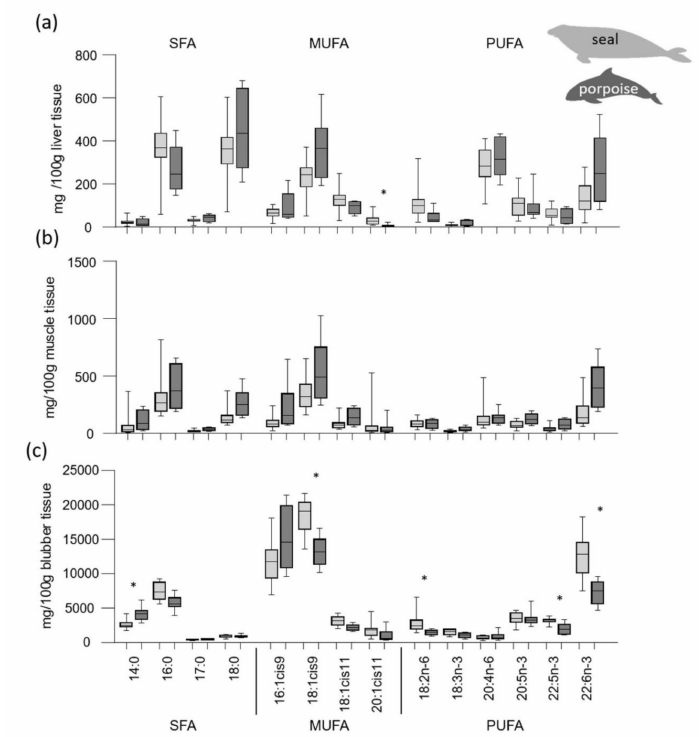
Figure 2. Single fatty acid concentrations (mg / 100 g fresh tissue) in liver ( a ), skeletal muscle ( b ), and blubber tissue ( c ) of grey seals (light grey boxes) and harbour porpoise (dark grey boxes), * significant di ff erent between both species (* p <